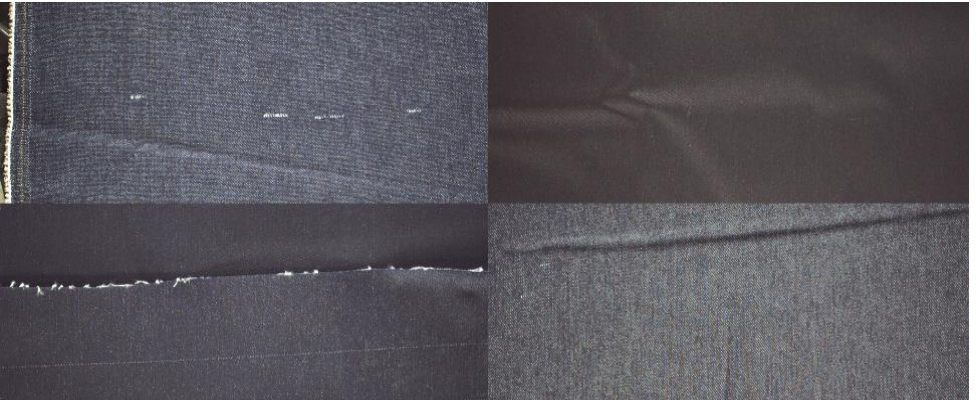
Figure 1. Some iconic defect images.